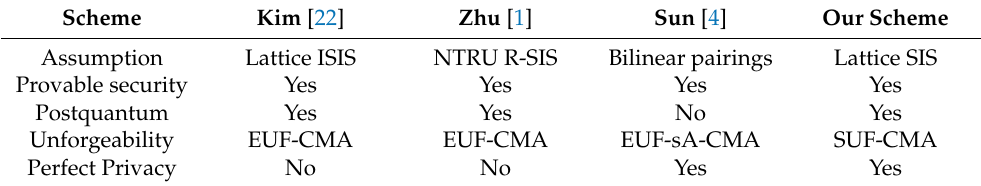
Table 3. A comparison of security